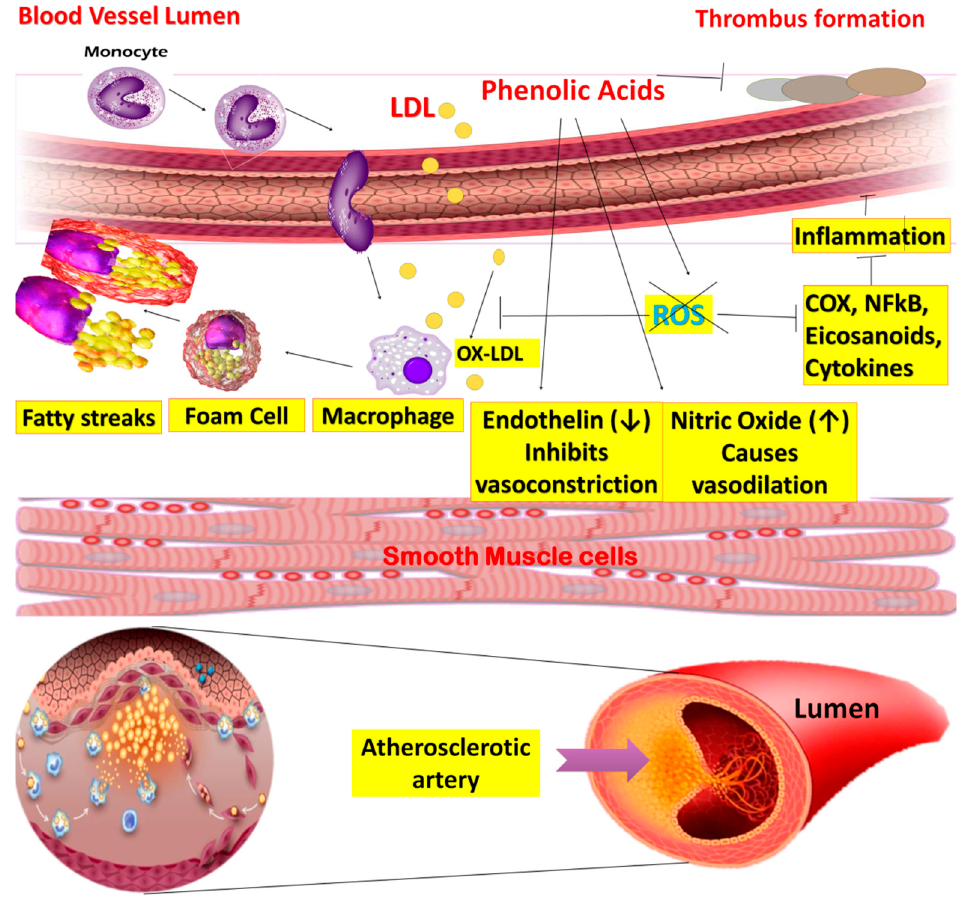
Figure 10. Mechanism of anti-atherosclerosis effect of phenolic acids.